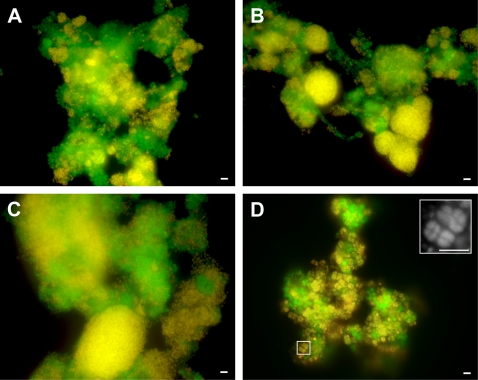
Representative FISH micrographs of the activated sludges analysed in this study.(A) EBPR28 sludge, (B) EBPR42 sludge, (C) EBPR55 sludge and (D) nEBPR70 sludge. Cells detected with probe EUBMIX only are green (A, B, C and D). Cells detected with both EUBMIX and PAO651 probes (A, B and C) and cells detected with both EUBMIX and ALF1b probes (D) are yellow-orange. Highlighted area in pane d corresponds to magnified region hybridised only with the ALF1b probe in the top right hand corner. Images taken under the different excitation wavelengths for CY3 and FITC were combined using Adobe Photoshop. Cells were observed under x 630 magnification, bars = 10 µm.